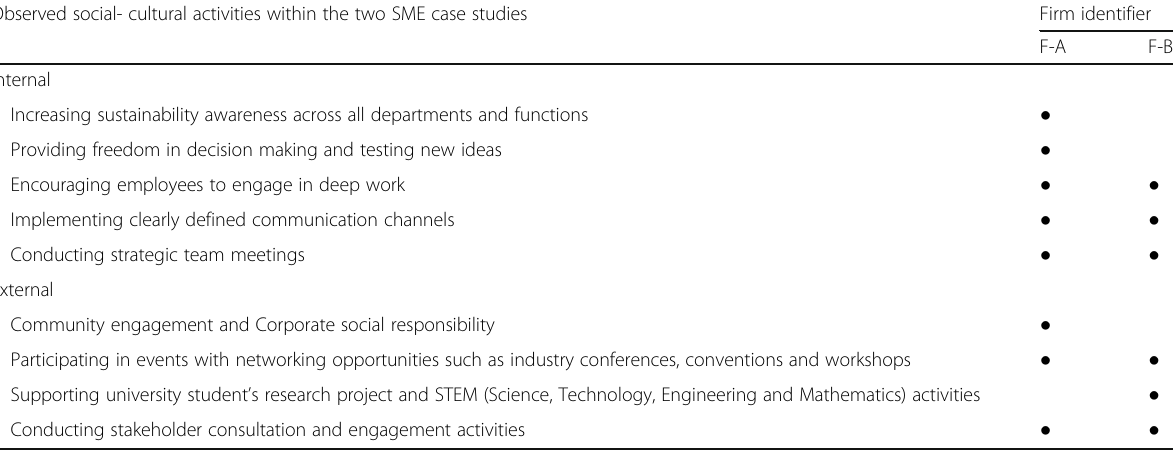
Table 6 Observed social-cultural activities in the two case study SMEs Observed social- cultural activities within the two SME case